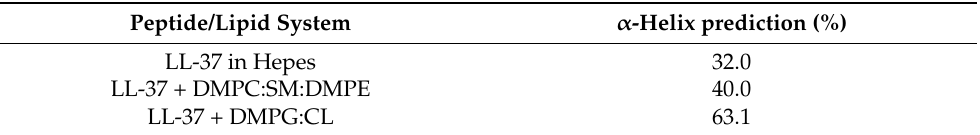
Table 1. Prediction of the secondary structure analysis of the peptide LL-37 in buffer and in different lipid systems.